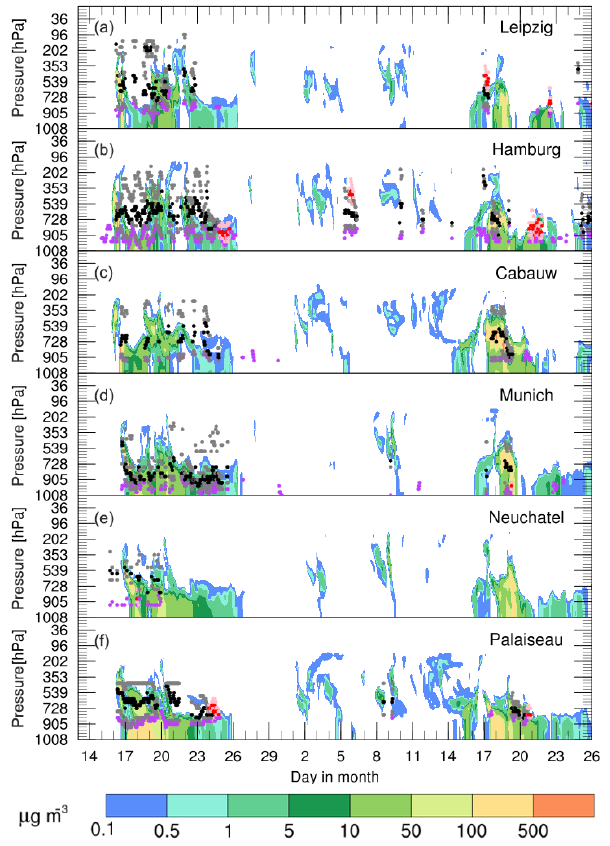
Figure 8. Height–time profiles of ash concentrations from the eEMEP model, including gravitational settling, at the six EAR- LINET lidar stations (see Fig. 6) in the April–May 2010 episode (contour graph in the background). Lidar-detected upper and lower heights of the ash layer are presented as grey dots. The lidar- retrieved centre of mass for ash is plotted as black dots. For mixed layers where ash is identified with continental aerosol, the height of the layer is presented as light pink dots, and centres of mass are red dots. The height of the planetary boundary layer is shown in vi- olet. Due to weather conditions and technical difficulties, the lidar measurements are not a continuous series.